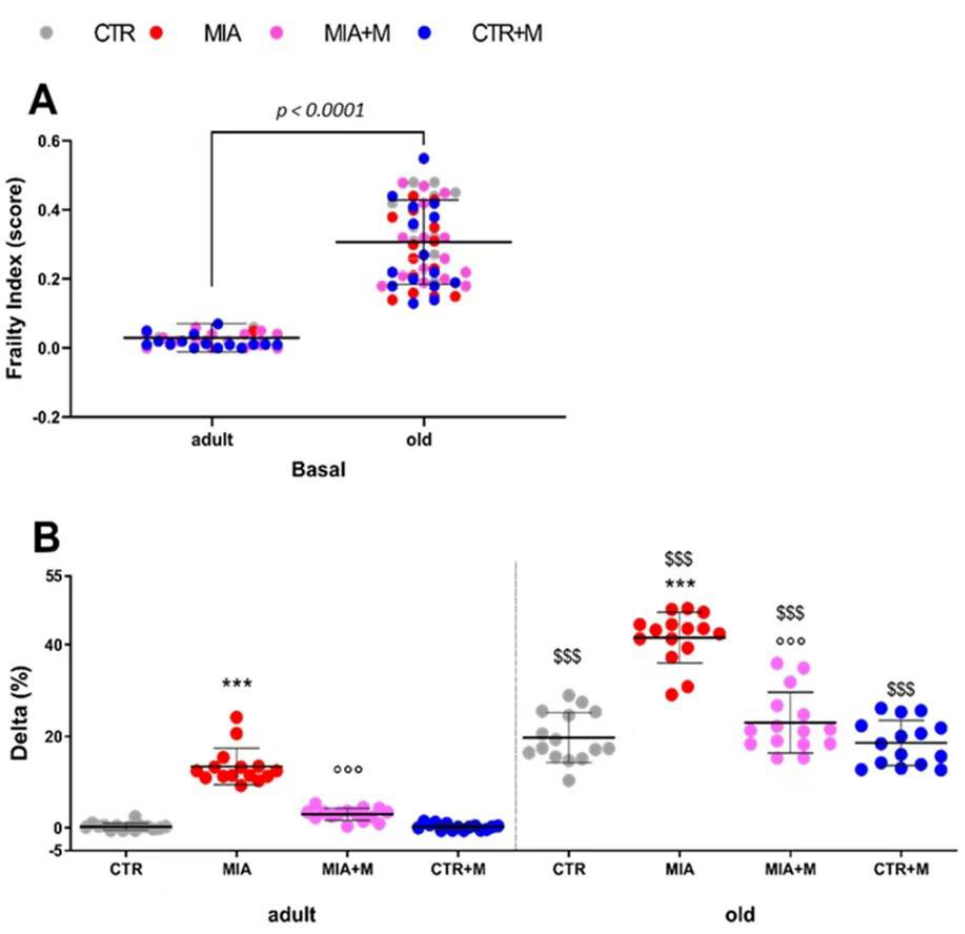
Figure 3. Frailty Index. Frailty index (FI) was assessed at baseline ( A ) and after 14 days from OA. ( A ) Frailty index score of adult (11-week-old) and old (20-month-old) mice before OA induction. ( B ) The delta percentage of basal FI (day 0) and final FI (day 14) of adult and old mice were calculated. OA was induced by intra-articular administration of MIA (day 0; 1 mg in right knee) and morphine treatment (2.5 mg/kg, s.c.) was performed once daily for 1 week (from day 7 to day 14). Data represent mean ± SD of 60 mice/group ( A ) or 15 mice/group ( B ). Statistical analysis was performed by mean of unpaired t-test ( A ) or one-way ANOVA followed by Bonferroni’s post-test ( B ). ( A ) t = 16.68, df = 118; ( B ) Treatments: F (7, 112) = 161.6, p < 0.001. *** p < 0.001 vs. respective age-CTR (intra-articular treated with saline); ◦◦◦ p < 0.001 vs. respective age-MIA; $$$ p < 0.001 vs. respective adult treatment group.